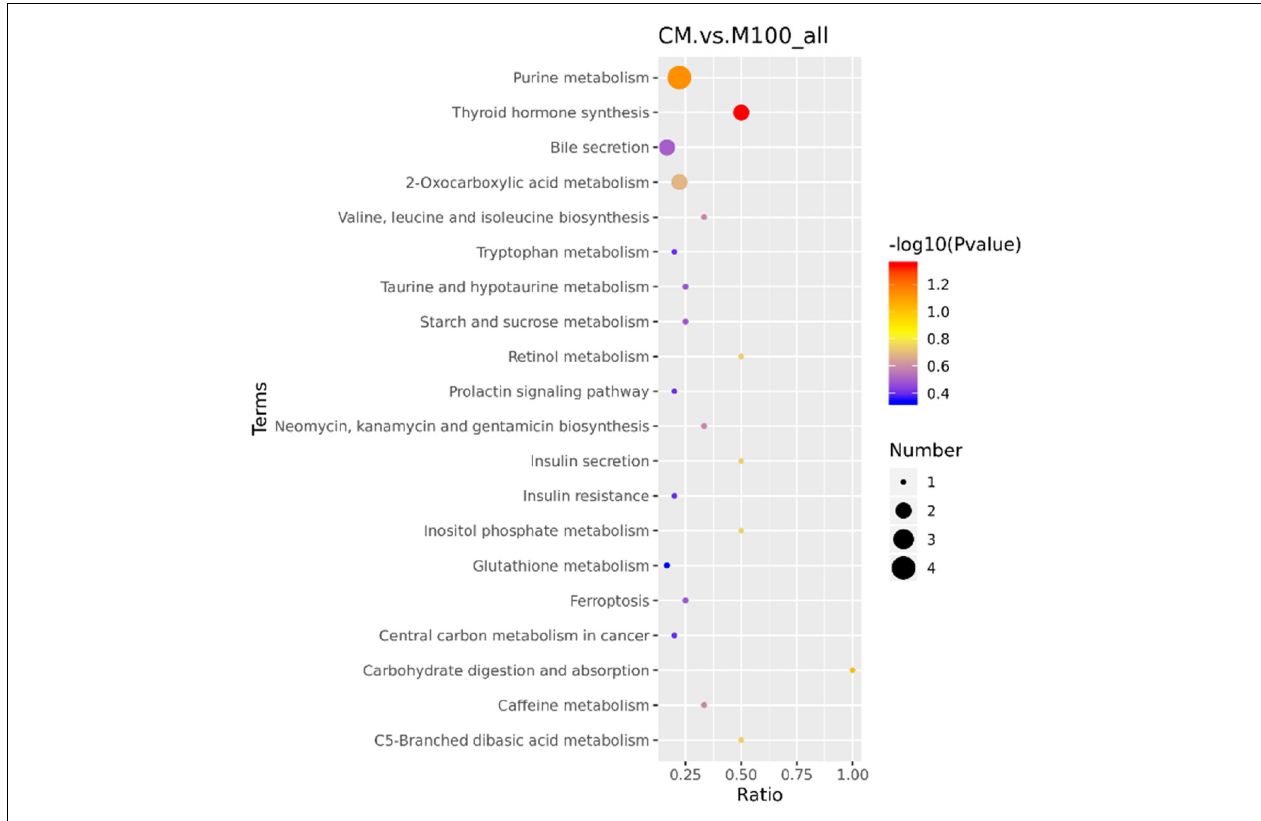
FIGURE 4 | Kyoto Encyclopedia of Genes and Genomes pathways analysis of differentially expressed metabolites in response to Axn. The ordinate represents the top 20 KEGG terms significantly enriched by the DEMs, the abscissa indicates the rich factor between two sampling